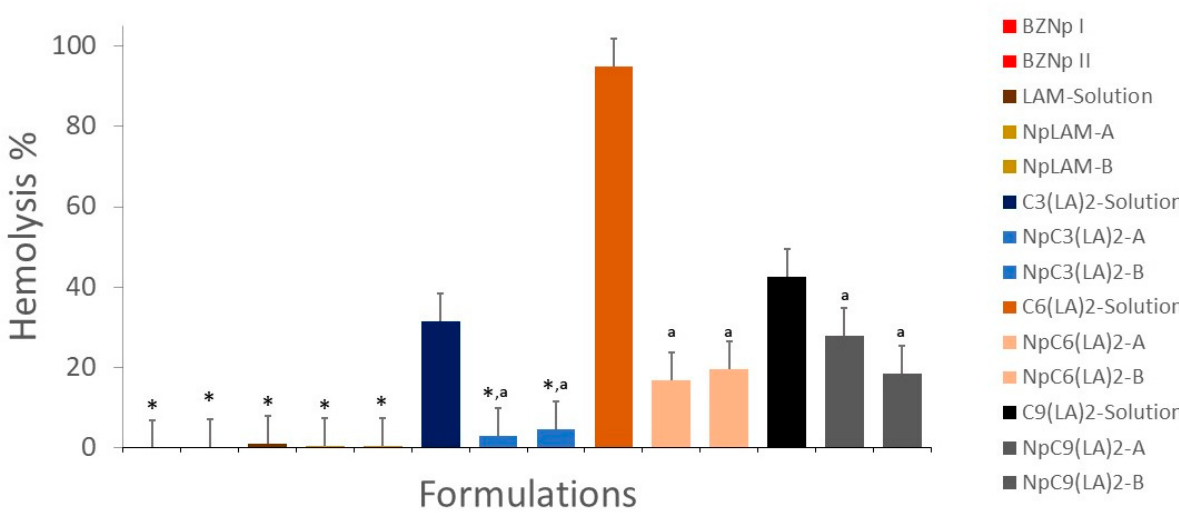
Figure 17. Hemolytic activity of the surfactants´ solutions (35.6 µg/mL) and loaded zein nanoparticles prepared by methods A and B. The results are expressed as a percentage using PBS (pH7.4) (negative control) as reference. * Significatively reduced the hemolytic activity compared to the respective solution ( p < 0.05). ᵃ Equal to the negative control ( p > 0.05). Data submitted in pairs to one-way ANOVA with post-hoc Tukey test when p < 0.05.